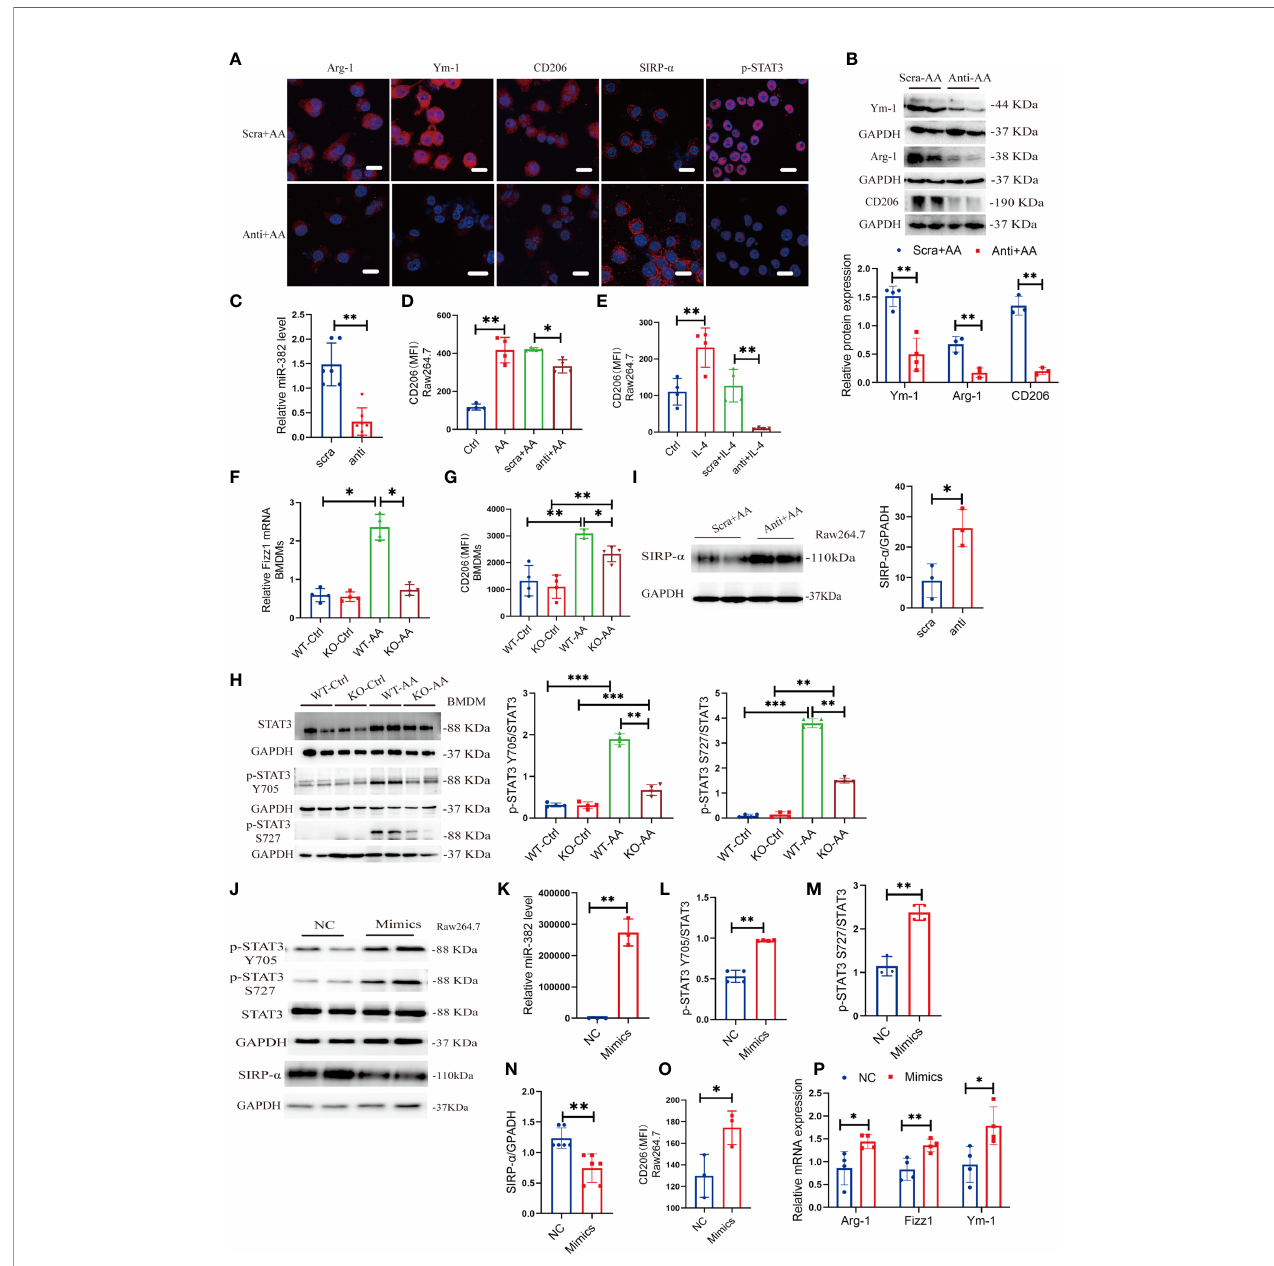
FIGURE 6 | Suppression or overexpression of miR-382 is implicated in M2-like macrophage activation in vitro. (A) Immuno fl uorescence staining for Arg-1, Ym-1, CD206, SIRP- a , and p-STAT3 in Raw264.7 cells with anti-scramble or anti-miR-382 with AA (10 m g/ml 48 h) induction. Scale bars, 20 m m. (B) Representative Western blot images and relative quanti fi cation for Ym-1, Arg-1, and CD206 in Raw264.7 cells between anti-scramble+ AA and anti-miR-382+ AA groups. (C) Abundance of miR-382 in anti-scramble or anti-miR-382 with AA (10 m g/ml 48 h) induction. U6 was used as an endogenous control. (D) MFI of CD206+ macrophages among control, AA, anti-scramble +AA and anti-miR-382+ AA groups in Raw264.7 cells. (E) MFI of CD206+ macrophages among control, IL-4, anti- scramble +IL-4, and anti-miR-382+ IL-4 groups in Raw264.7 cells. (F) mRNA level of Fizz1 in BMDMs from WT and KO mice following AA treatment. 18s served as standard. (G) MFI of CD206+ macrophages in BMDMs from WT and KO mice following AA treatment. (H) Images and quanti fi cation of Western blot for p-STAT3 Y705, p-STAT3 S727, and STAT3 in BMDMs between WT and KO mice following AA treatment. GAPDH was used an endogenous control. (I) Images and quanti fi cation of Western blot for SIRP- a in Raw264.7 cells in anti-scramble and anti-miR-382 with AA treatment. GAPDH served as standard. (J) Images of Western blot for p-STAT3 Y705, p-STAT3 S727, STAT3, and SIRP- a in NC and miR-382 mimic groups in Raw264.7 cells. GAPDH served as standard. (K) Abundance of miR-382 between NC and Mimics groups in Raw264.7 cells. U6 was used as an endogenous control. (L, M) Ratio of p-STAT3 Y705/STAT3 and p-STAT3 S727/ STAT3 in NC and miR-382 mimic groups in Raw264.7 cells. (N) Quanti fi cation of Western blot for SIRP- a in Raw264.7 cells in NC and Mimics groups. (O) MFI of CD206+ macrophages between NC and Mimics groups in Raw264.7 cells. (P) Relative mRNA levels of Arg-1, Fizz1, and Ym-1 in Raw264.7 cells after overexpression of miR-382. *P < 0.05; **P < 0.01; ***P < 0.001;